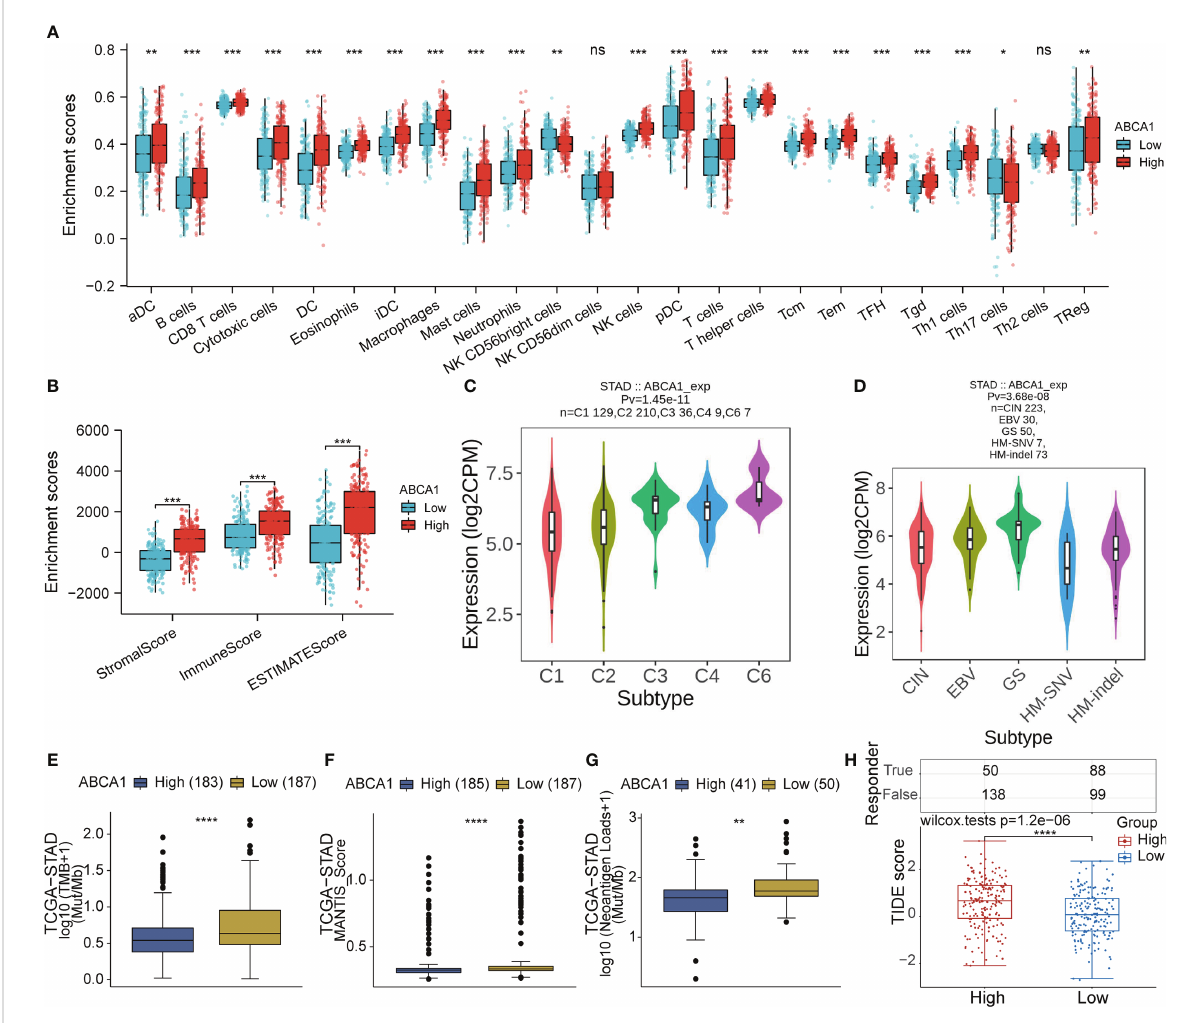
FIGURE 10 Correlation analysis of ABCA1 expression and immune characteristics in STAD. (A, B) Differential analysis of the level of immune in fi ltration between high and low expression groups of ABCA1 was performed in STAD by the ssGSEA and estimate algorithms. (C, D) Differential analysis of ABCA1 expression levels between different immunological and molecular subtypes in STAD using the TISIDB database. (E-G) Differential analysis of TMB, MSI, and neoantigen loads between high and low ABCA1 expression groups was performed in STAD using the CAMOIP database. (H) Differential analysis of TIDE scores between high and low ABCA1 expression groups in STAD. (ns: p > 0.05, *: p ≤ 0.05, **: p ≤ 0.01, ***: p ≤ 0.001, ****: p ≤